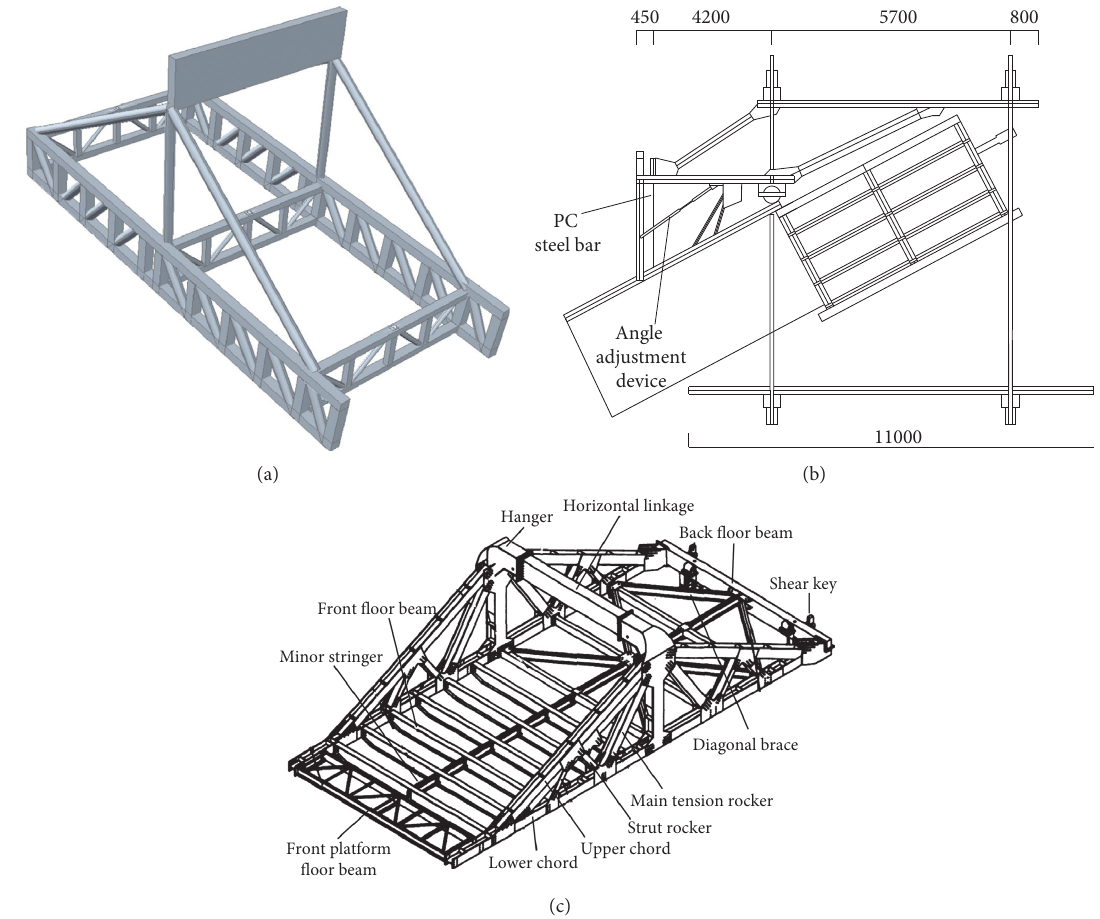
Figure 2: Structural diagrams of the mainstream form travelers (unit: mm). (a) European style. (b) Japanese style. (c) Chuan